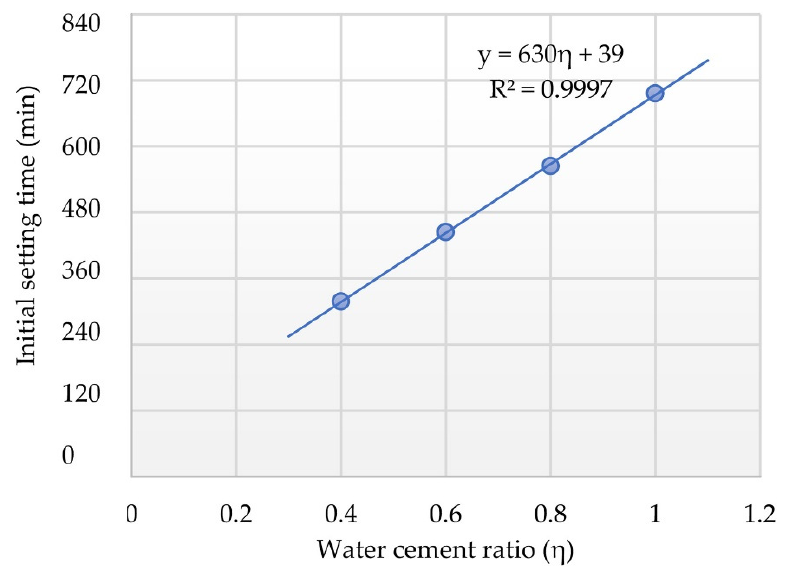
Figure 5. Relationship between water–cement ratio and initial setting time.